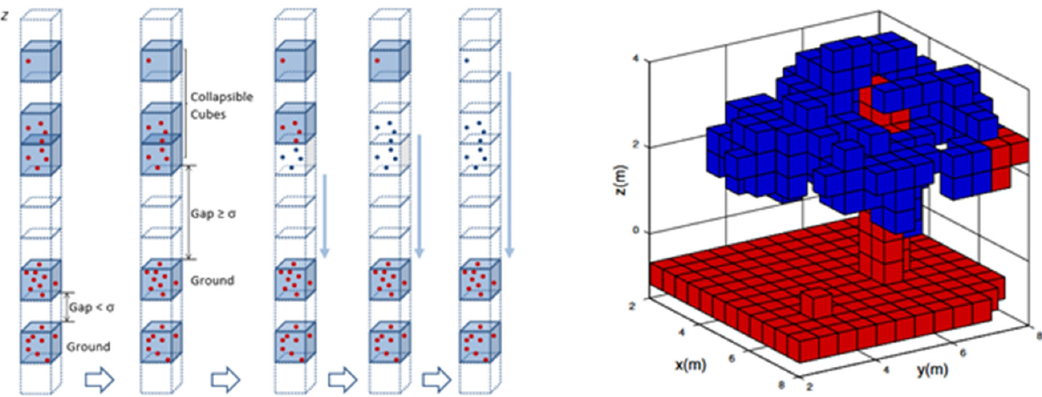
Figure 7. Illustration of the “Collapsible Cubes” procedure to identify “ground” and “non-ground” points